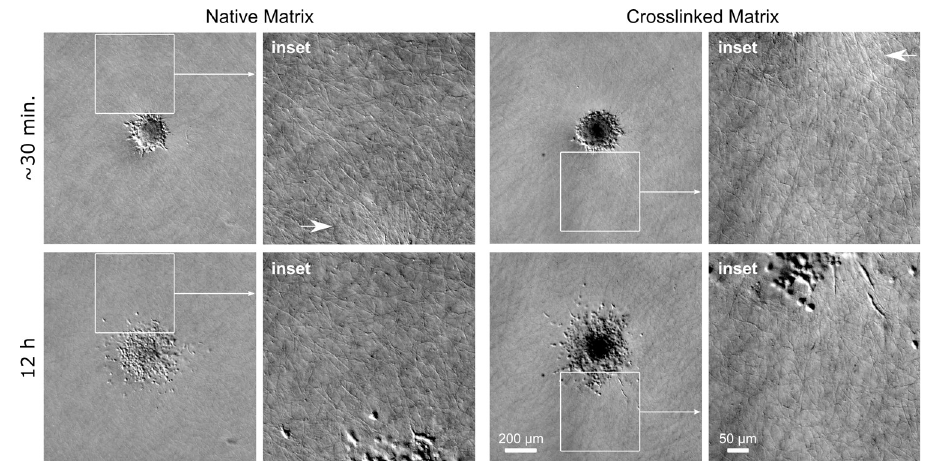
Fig 2. Cells invade native and crosslinked matrices as individuals. Representative DIC images of HT-1080 cells invading from spheroids into native or crosslinked collagen matrices. Images were acquired as soon as possible after seeding (~30 min) and then of the same spheroid at approximately 12 h. Cells invaded radially out of the spheroid as individuals. Fiber alignment was observed in the vicinity of the spheroids in both native and crosslinked matrices (see “inset” images on right; arrows). Scalebar for low-magnification images (left) = 200 μ m; scalebar for insets (right) = 50 μ m.